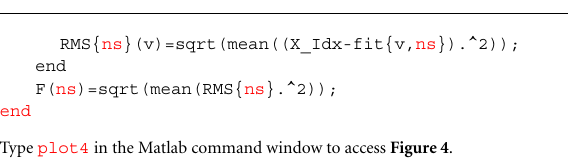
FIGURE 3 |The computation of local fluctuations, RMS{1} , around linear (A), quadratic (B), and cubic trends (C) by Matlab code 3 ( m = 1 , m = 2 , and m = 3 , respectively). The red dashed line is the fitted trend, fit{v} , within eight segments of sample size